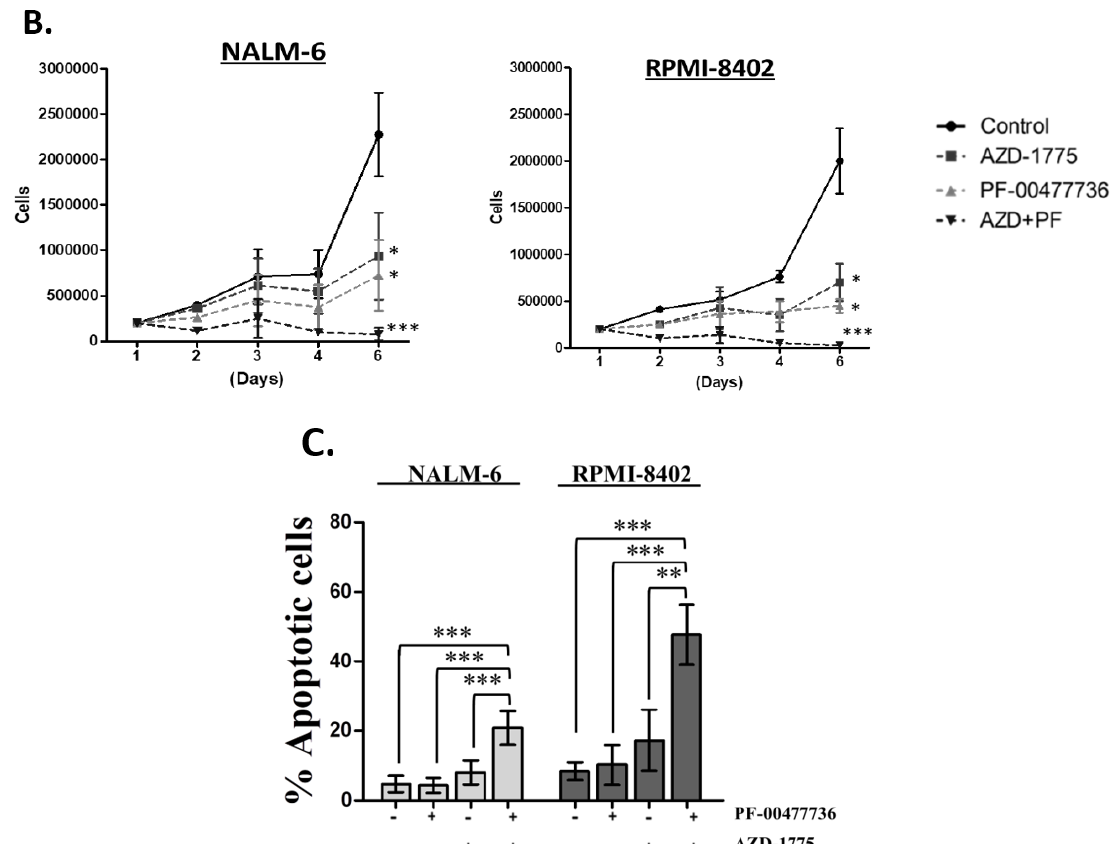
Figure 1. The simultaneous inhibition of CHK1/CHK2 and WEE1 synergizes in term of reduction of cell viability and induction of apoptosis in ALL cell lines. ( A ) Cell viability of RPMI-8402 and NALM-6 cell lines treated simultaneously with increasing concentration of PF-00477736 (nM) and AZD-1775 (nM) for 24, 48 and 72 h. Abbreviations PF = PF-00477736, AZD = AZD-1775. ( B ) Growth curve analysis of RPMI-8402 and NALM-6 cell lines treated for 24 h with AZD-1775 (185 nM; dark grey full square) and PF-00477736 (25 and 250 nM respectively; light gray full triangle). In the graph AZD-1775 in combination with PF-00477736 is named AZD + PF(black full triangle). ( C ) Apoptosis analysis on RPMI-8402 and NALM-6 cell lines treated for 24 h with AZD-1775 (185 nM) and PF-00477736 (25 and 250 nM respectively). In the figures statistical significance was represented as asterisks and in detail: p < 0.05 one asterisk (*); p < 0.01 two asterisks (**); p < 0.001 three asterisks (***).